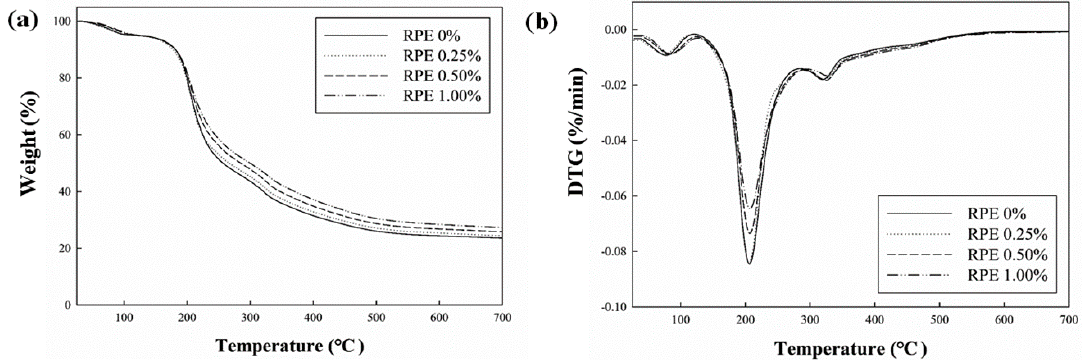
Figure 5. Thermogravimetric analysis (TGA) ( a ) and derivative TGA (DTGA) ( b ) of the CJP films containing different concentrations of RPE.